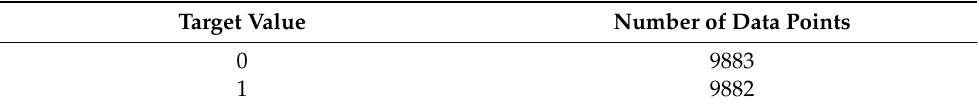
Table 8. Testing Data Point